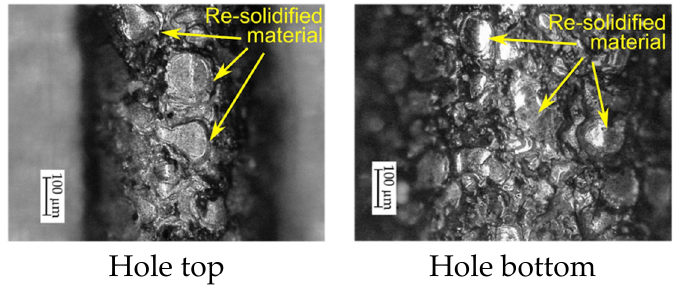
Figure 14. Images of the internal surface of the through hole.